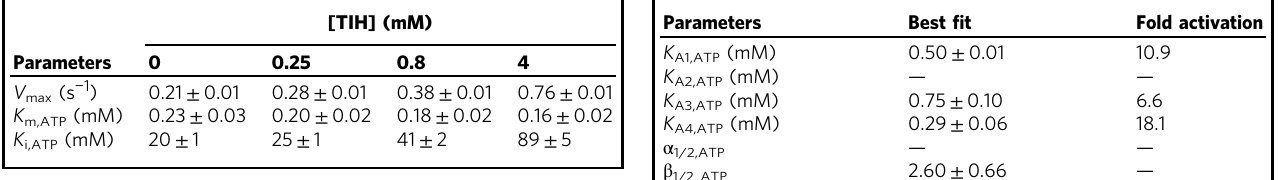
Table 2 Steady-state kinetic parameters for ATP-PRT activation in the presence of L